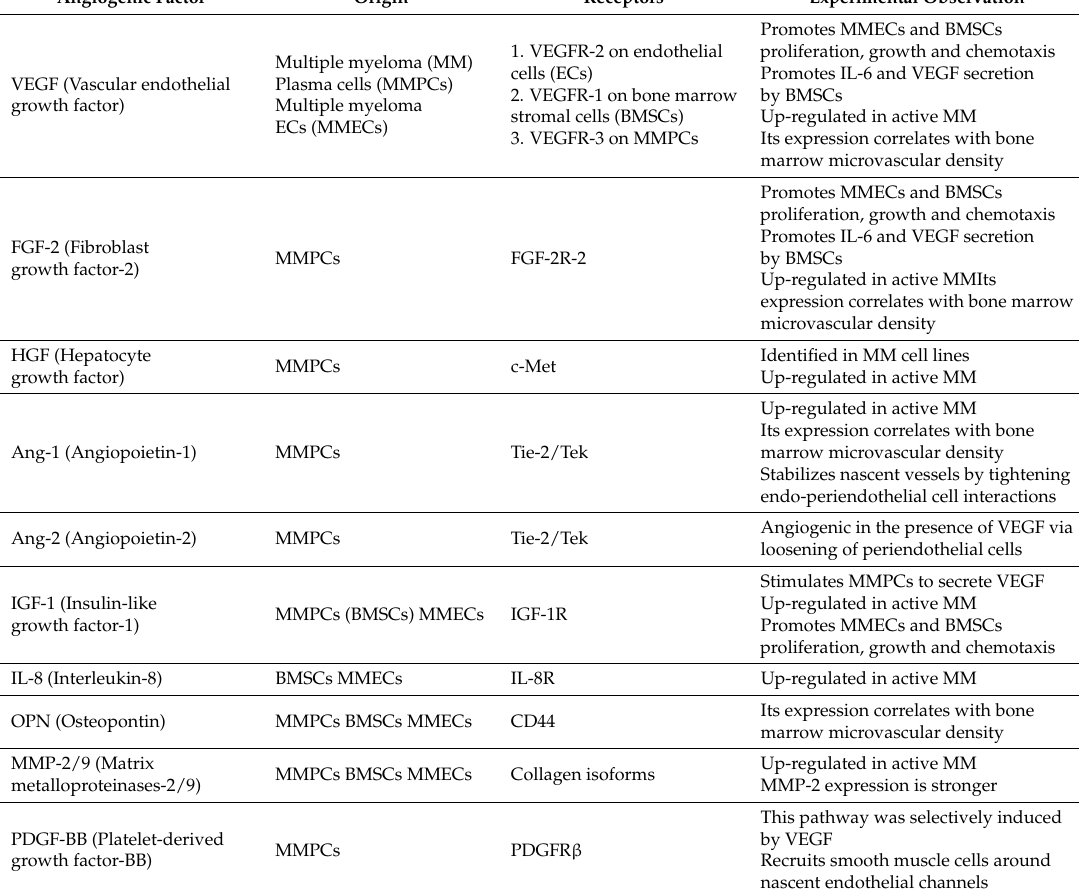
Table 1. Main angiogenic factors in active multiple myeloma (MM)